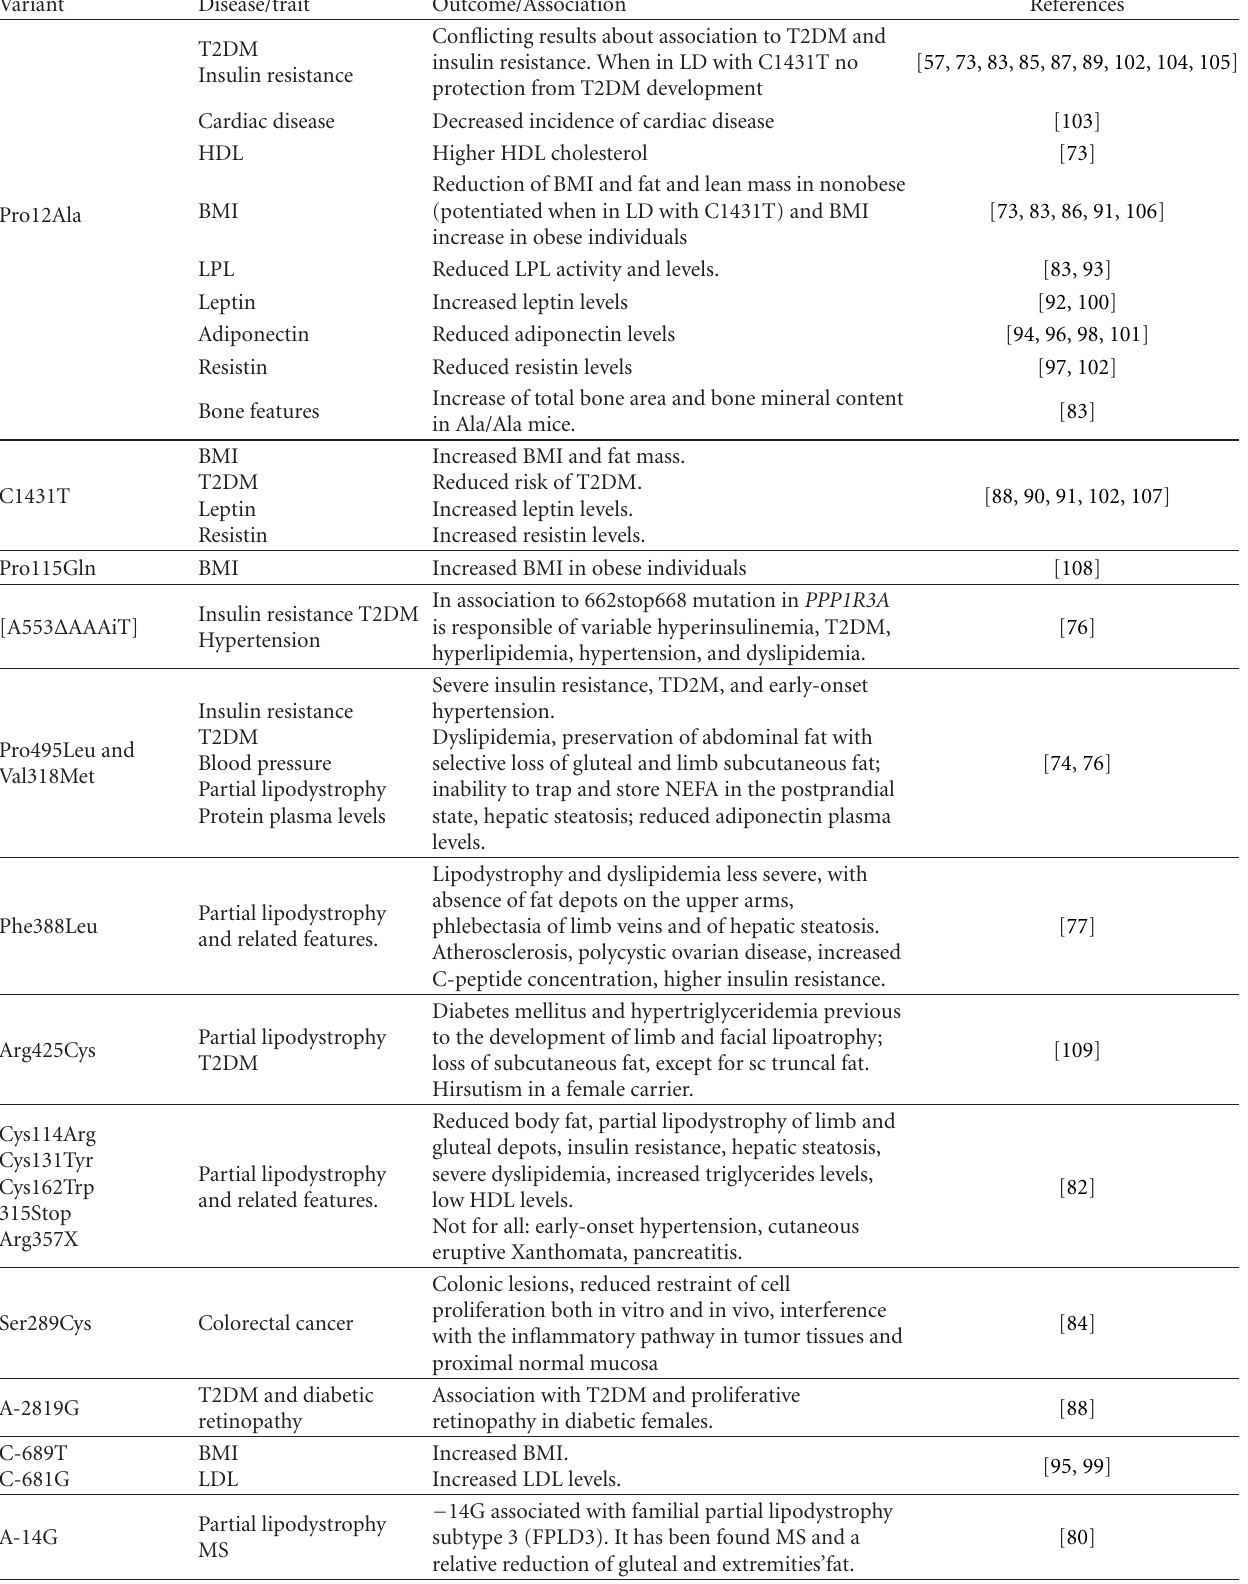
Table 1: Nucleotide variations within coding and regulatory regions of PPARG.